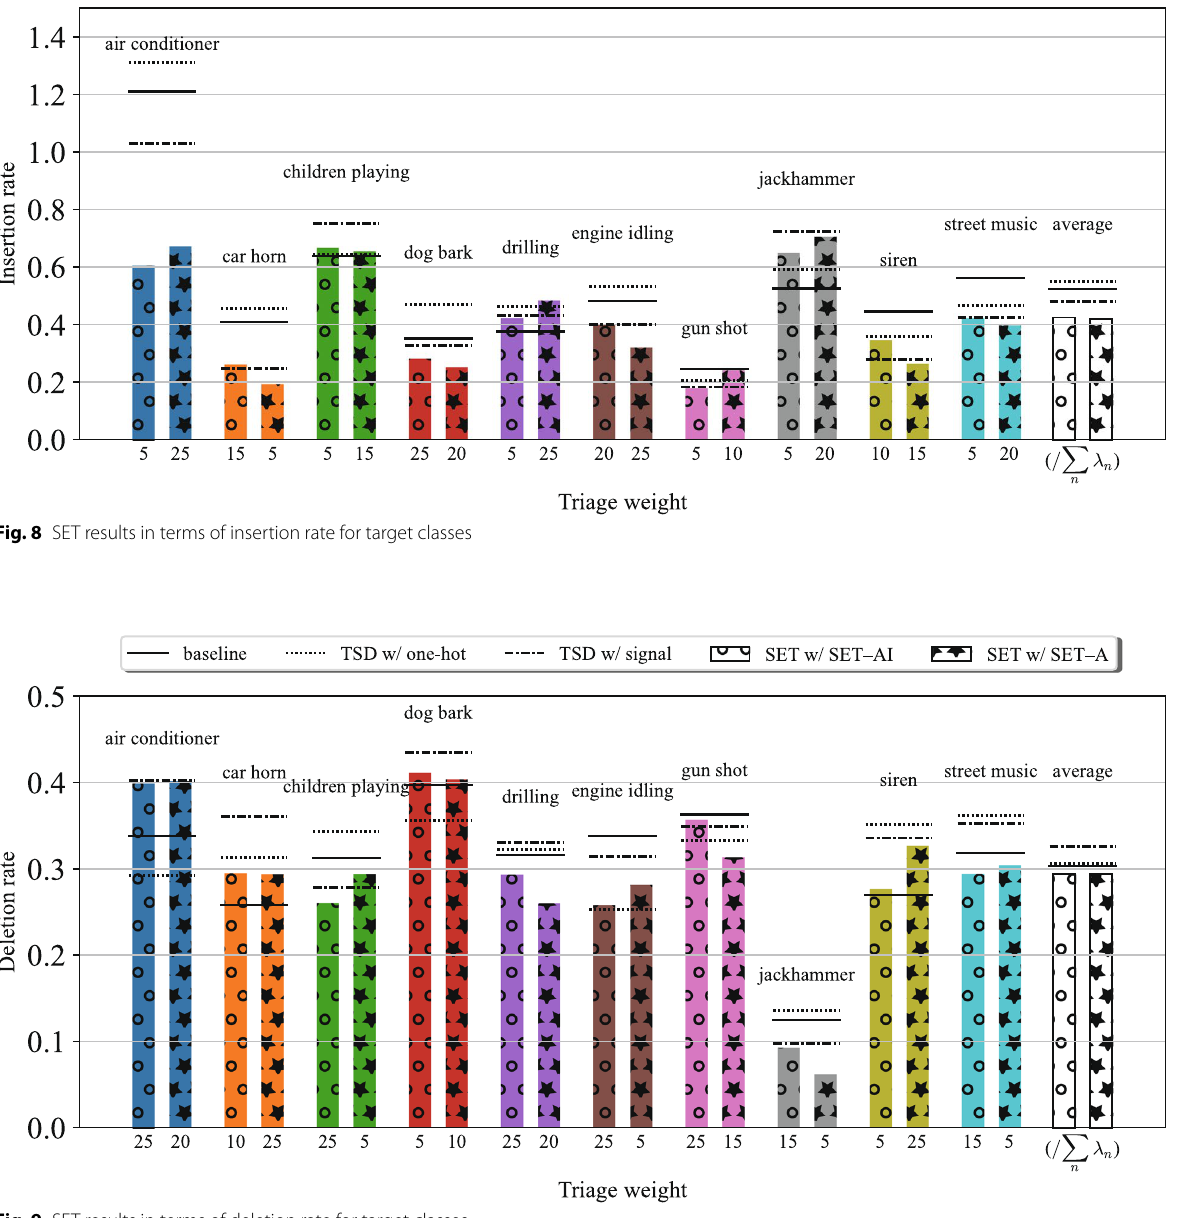
Fig. 9 SET results in terms of deletion rate for target